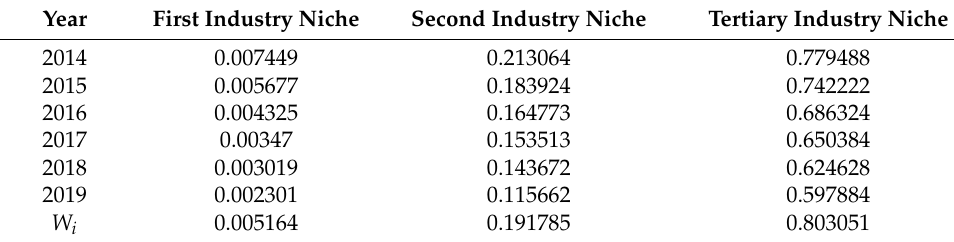
Table 5. Beijing’s industrial niche from 2014 to 2019.